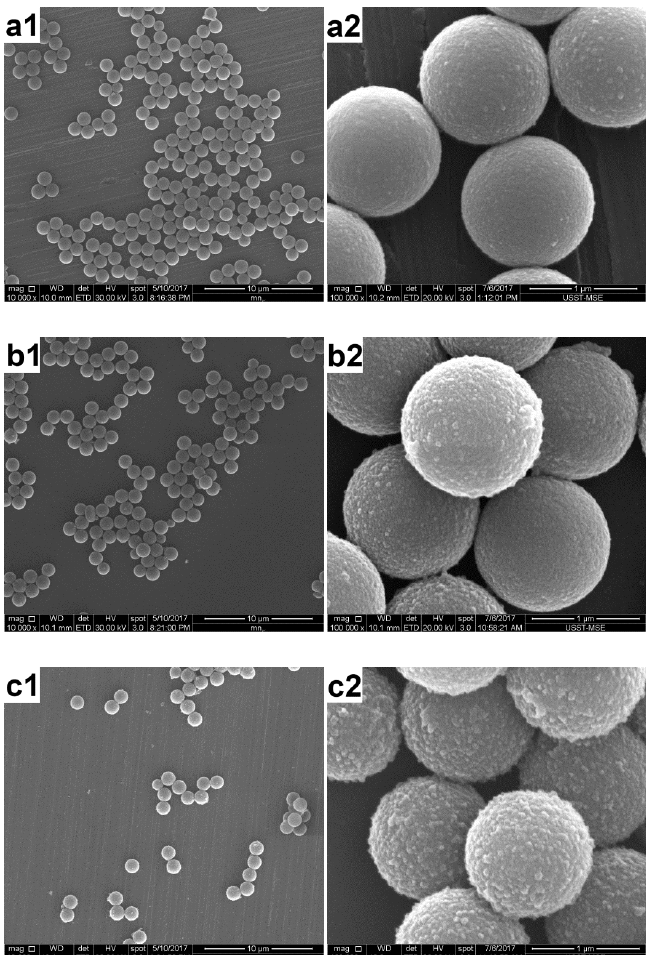
Figure 6. SEM images of the products prepared with varied PS amounts and a fixed amount of AT (0.2 g) at various magnifications: ( a ) 0.2 g (run 5); ( b ) 0.1 g (run 6), and ( c ) 0.05 g (run 7).